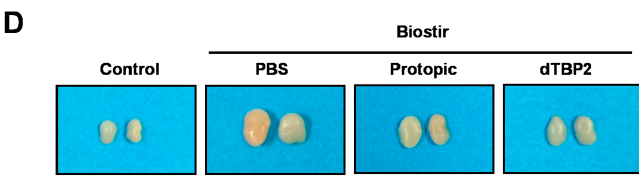
Figure 1. Dimerized translationally controlled tumor protein-binding peptide 2 ( dTBP2) ameliorates house dust mite-induced atopic dermatitis (AD)-like skin lesions and lymph node in Nishiki-nezumi Cinnamon/Nagoya (NC/Nga) mice. Biostir AD (100 mg) was applied twice every week for 3 weeks.